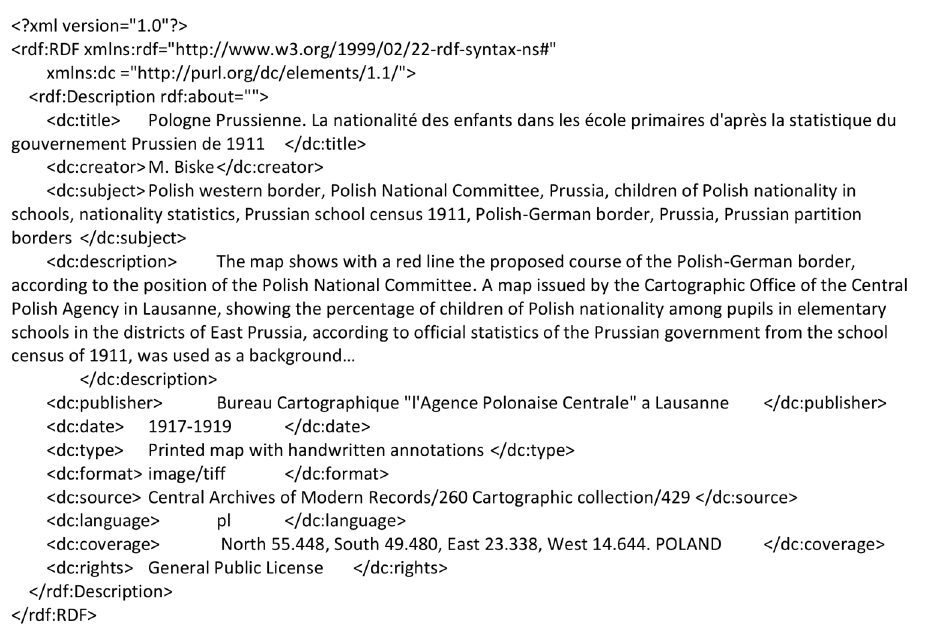
Fig. 7. Example of metadata saved in the RDF format (author’s